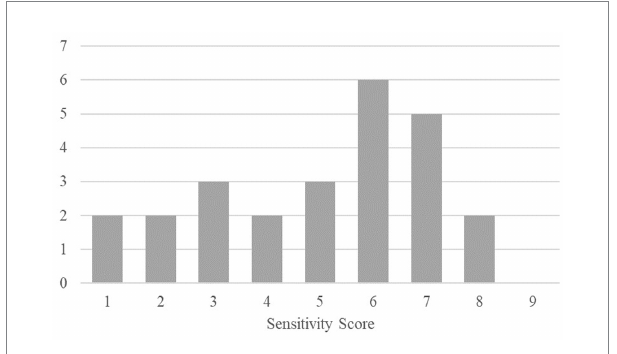
FIGURE 1 Distribution of sensitivity scores (from 1 to 9) in the